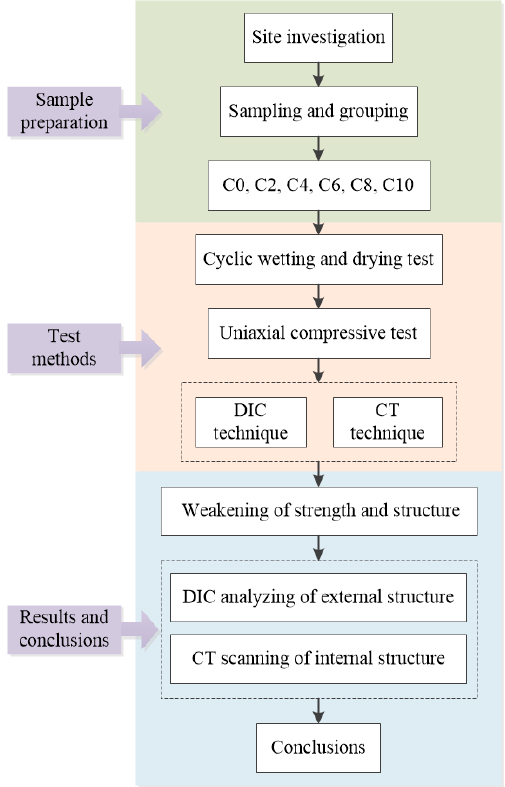
Figure 3. Flow chart of this study.